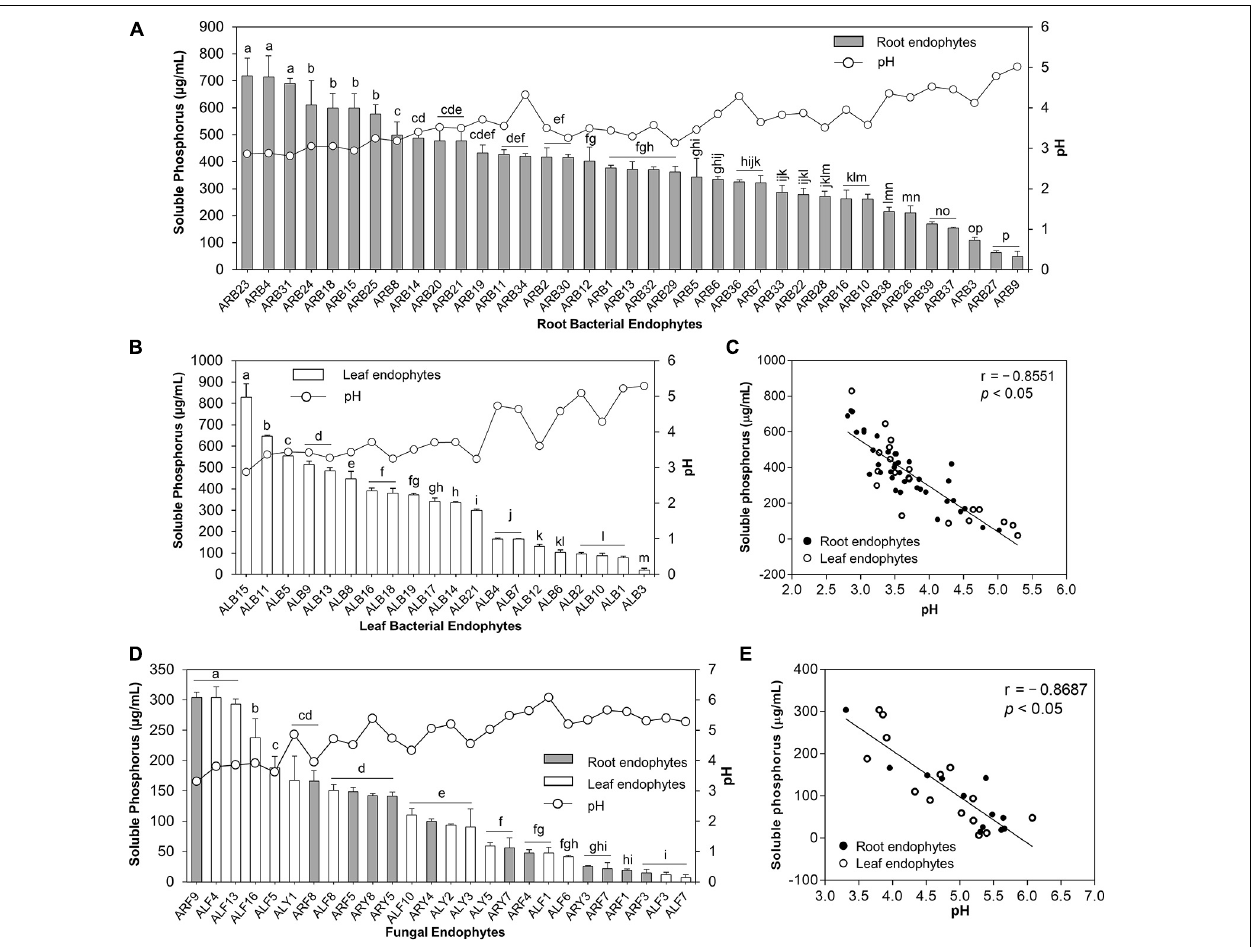
FIGURE 5 | Phosphate solubilization by bacterial and fungal endophytes isolated from leaf and root tissues of A. euchroma . Soluble P ( µ g/ml) in the culture supernatants was quantified, and pH of supernatants was measured. Phosphate solubilization by root (A) and leaf (B) associated bacterial endophytes and corresponding pH of the supernatants. (C) Correlation between pH and P solubilized by bacterial endophytes. (D) Phosphate solubilization of fungal endophytes and corresponding pH of the supernatants. (E) Correlation between pH and P solubilized by fungal endophytes. Bars with different alphabets indicate a significant difference ( p < 0.05) as calculated using Duncan’s multiple-range test. Error bars represent standard deviation ( n =